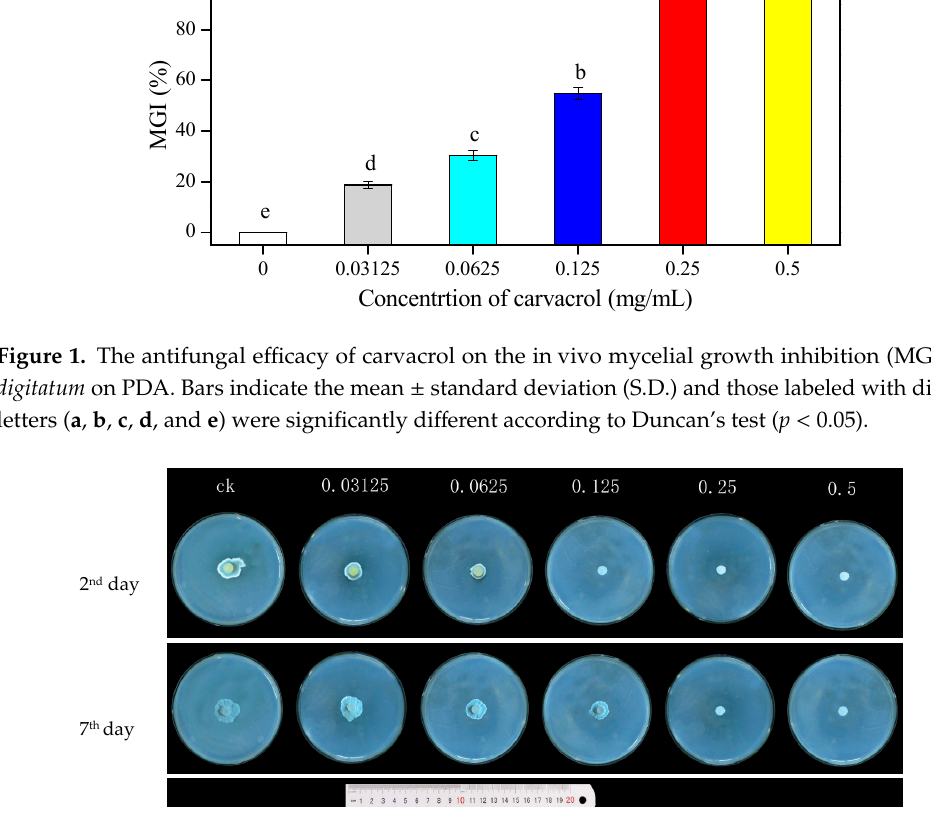
Table 1. The mycelial weights and water-retention rate of P. digitatum treated with several concentrations of carvacrol.